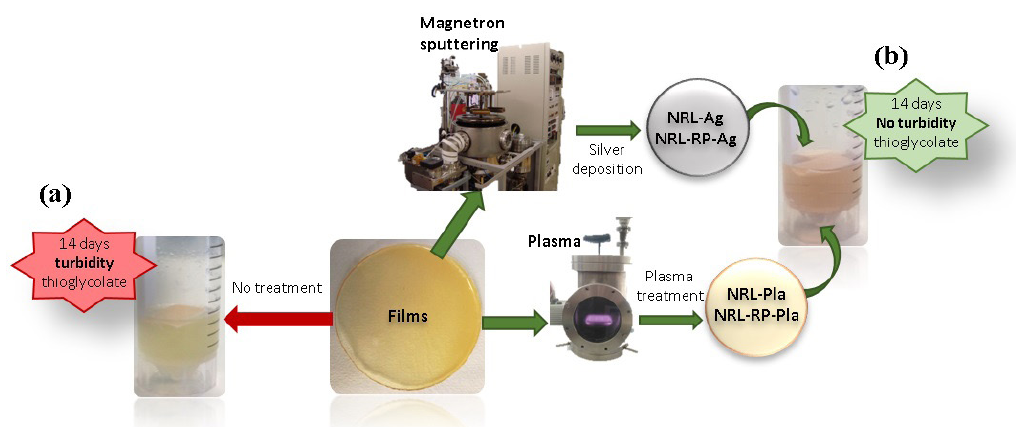
Figure 4. Scheme of the plasma sterilization process: (a) vial showing turbidity; (b) vial absent of turbidity films treated with plasma or silver coverage.